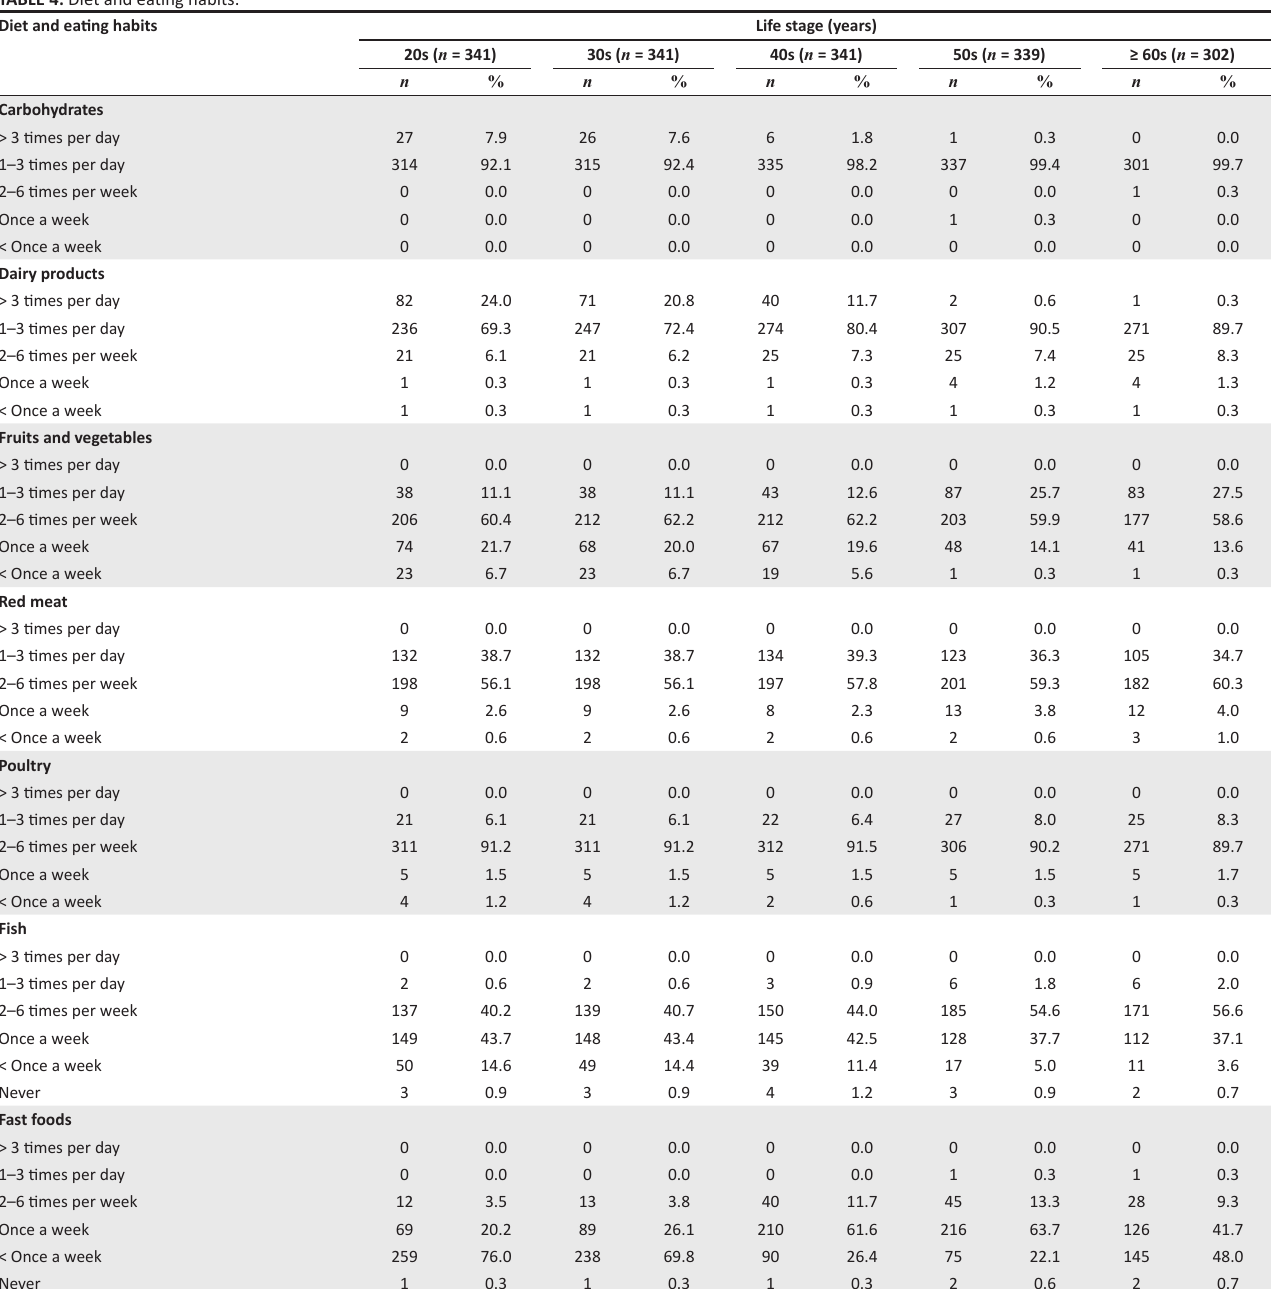
TABLE 4: Diet and eating habits. Diet and eating